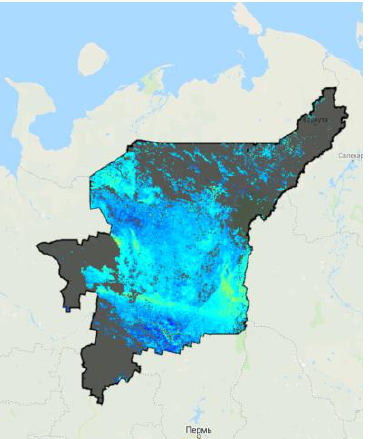
Figure 2. NDWI map for the republic of Komi with a cloud mask effect (2000-03-01)